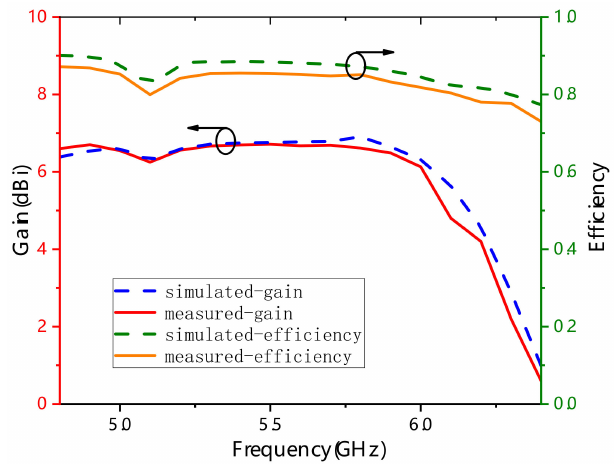
Figure 9. Simulated and measured gain and e ffi ciency of the proposed